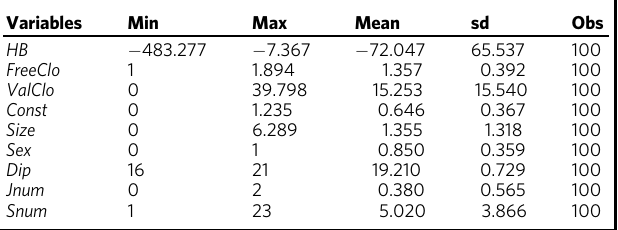
Table 3 Descriptive statistics of variables.